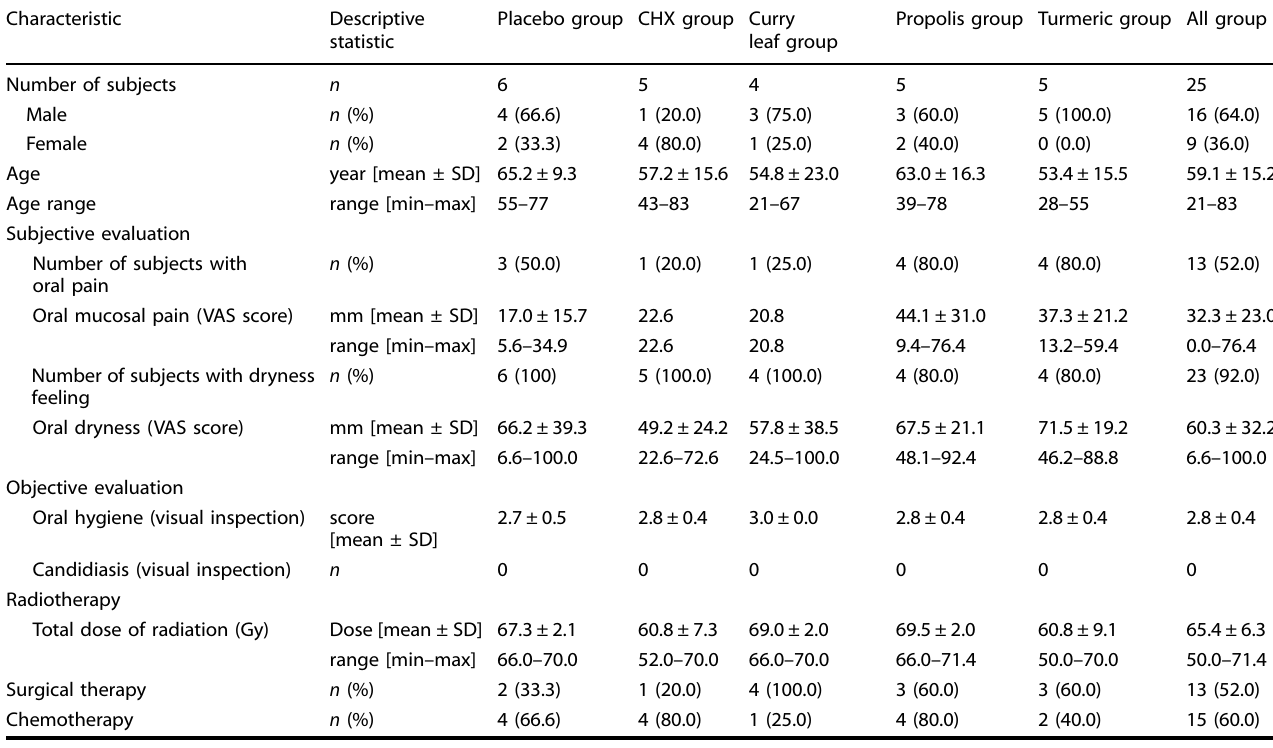
Table 1. Characteristics of 25 subjects a at baseline